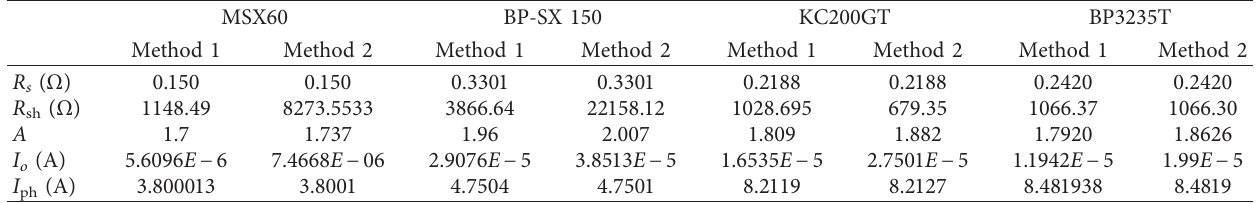
Table 6: A summary of appropriate parameters for MSX60, BP-SX 150, KC200GT, and